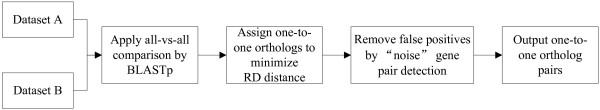
An outline of MSOAR.